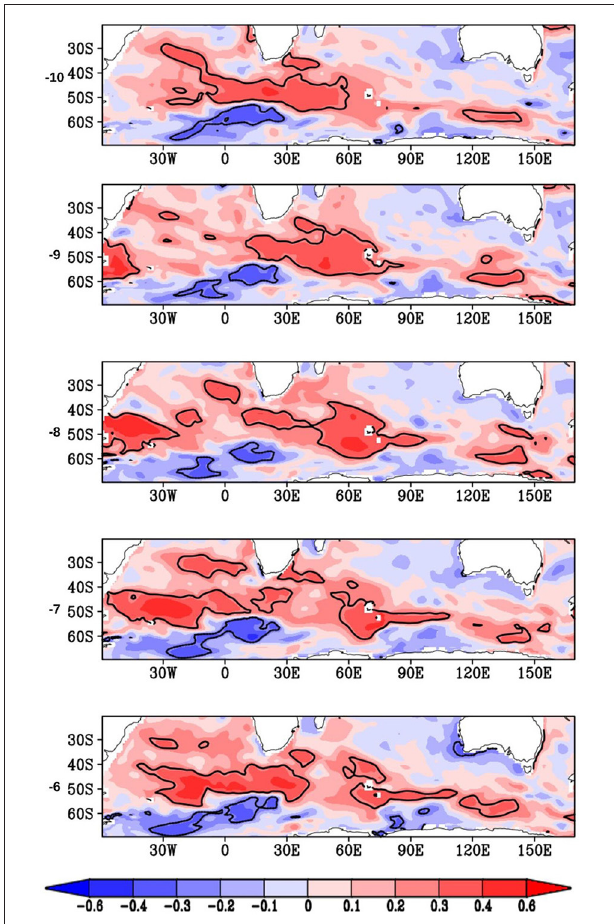
FIGURE 4 | Spatial distribution of the anomaly correlation of HadISST derived IODMI with vertically averaged subsurface temperatures from ORAS4 (over 300–800m depth) from previous years averaged annually. The “lag number” is the years over which the IOD lags the Southern Ocean signal. In all panels, significant correlations at 95% confidence are shown as contour lines (value at